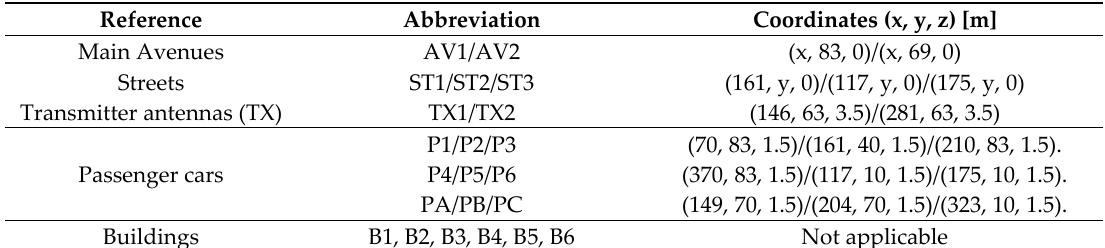
Table 1. Scenario